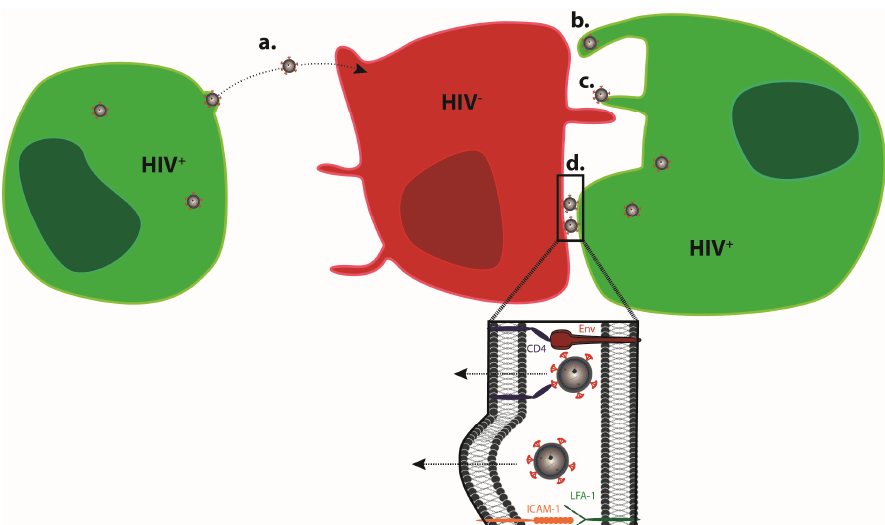
Figure 1. Transmission modes of HIV-1. Viral particles infect target cells via cell-free ( a ) or cell-associated ( b - d ) modes of transmission. ( a ) Viral particles bud at the surface of infected donor cells, mature, diffuse, and infect non-adjacent target cells. ( b , c ) Virions can bud at the tip ( b ) and surf along ( c ) filopodia to enter in adjacent target cells. In addition, infected and non-infected cells establish close contact, forming a virological synapse ( d ). Whether HIV-1 enters the target cell via fusion at the plasma membrane or following prior internalization [30,31] remains a matter of debate, and may depend on the nature of the target cell (reviewed in Reference [32]).